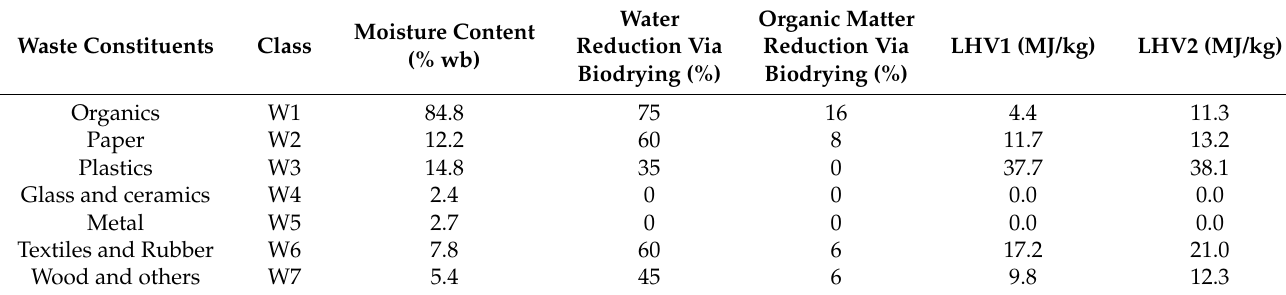
Table 3. Biological drying hypothesis.